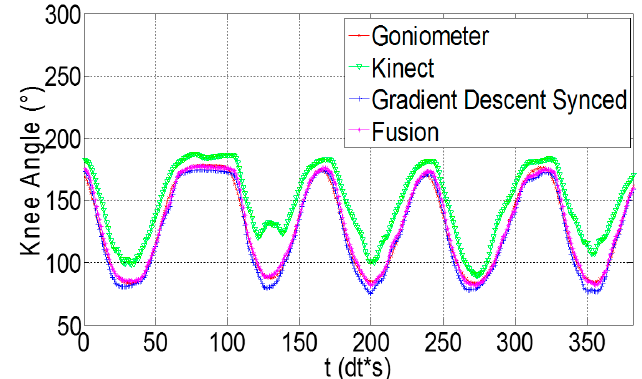
Figure 9. Knee angles estimated using goniometer, Kinect, gradient descent and sensor fusion, when IMU sensors are placed in the sagittal plane position.